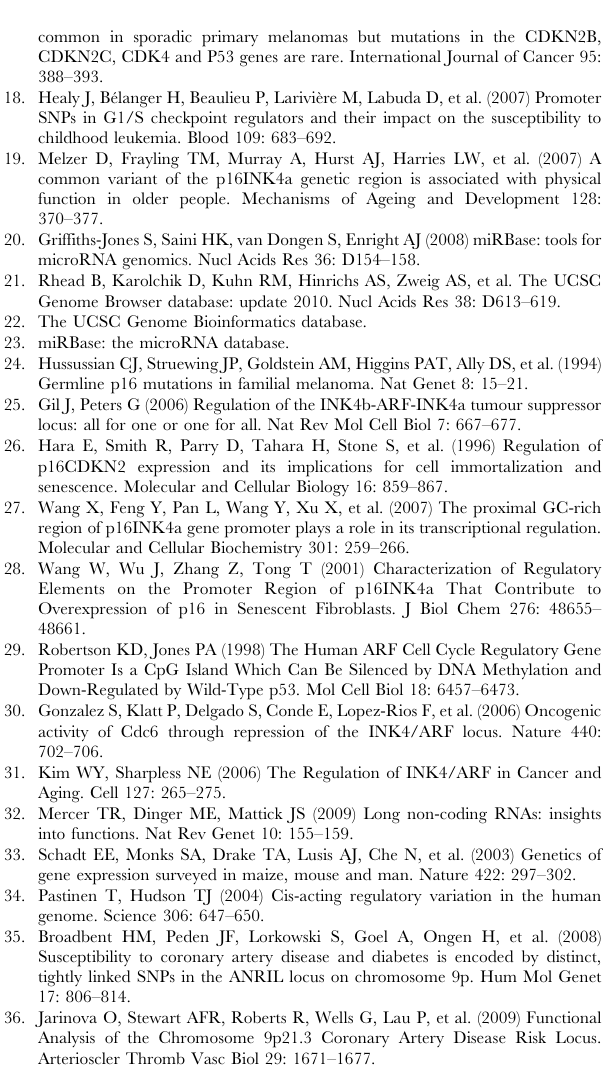
Table S3 Primer sequences.